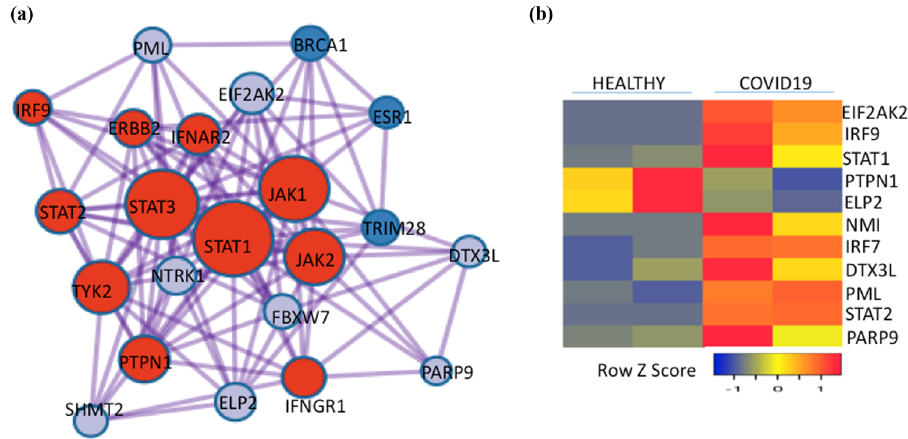
Figure 9: PIC - Venn network of STAT1 and other critical hubs involved in interferon signaling and di ff erential regulation in healthy and COVID19 patients. ( a ) Common protein interaction network of STAT1 and other critical hubs JAK1, JAK2, TYK2, STAT2, STAT3, and IRF9 revealed by PIC - Venn analysis in interferon signaling. Red, Blue and gray colors are used to highlight di ff erent hubs in the network. ( b ) Regulation of expression of the interferon hubs in the lung biopsies of healthy controls and COVID - 19 patients. Expression levels of selected genes in healthy and COVID - 19 lung samples are shown. Low and high expression levels are represented by blue and red, respectively. RNA expression values are normalized by DEseq2 and shown as a heat map. Data from two samples for each condition are